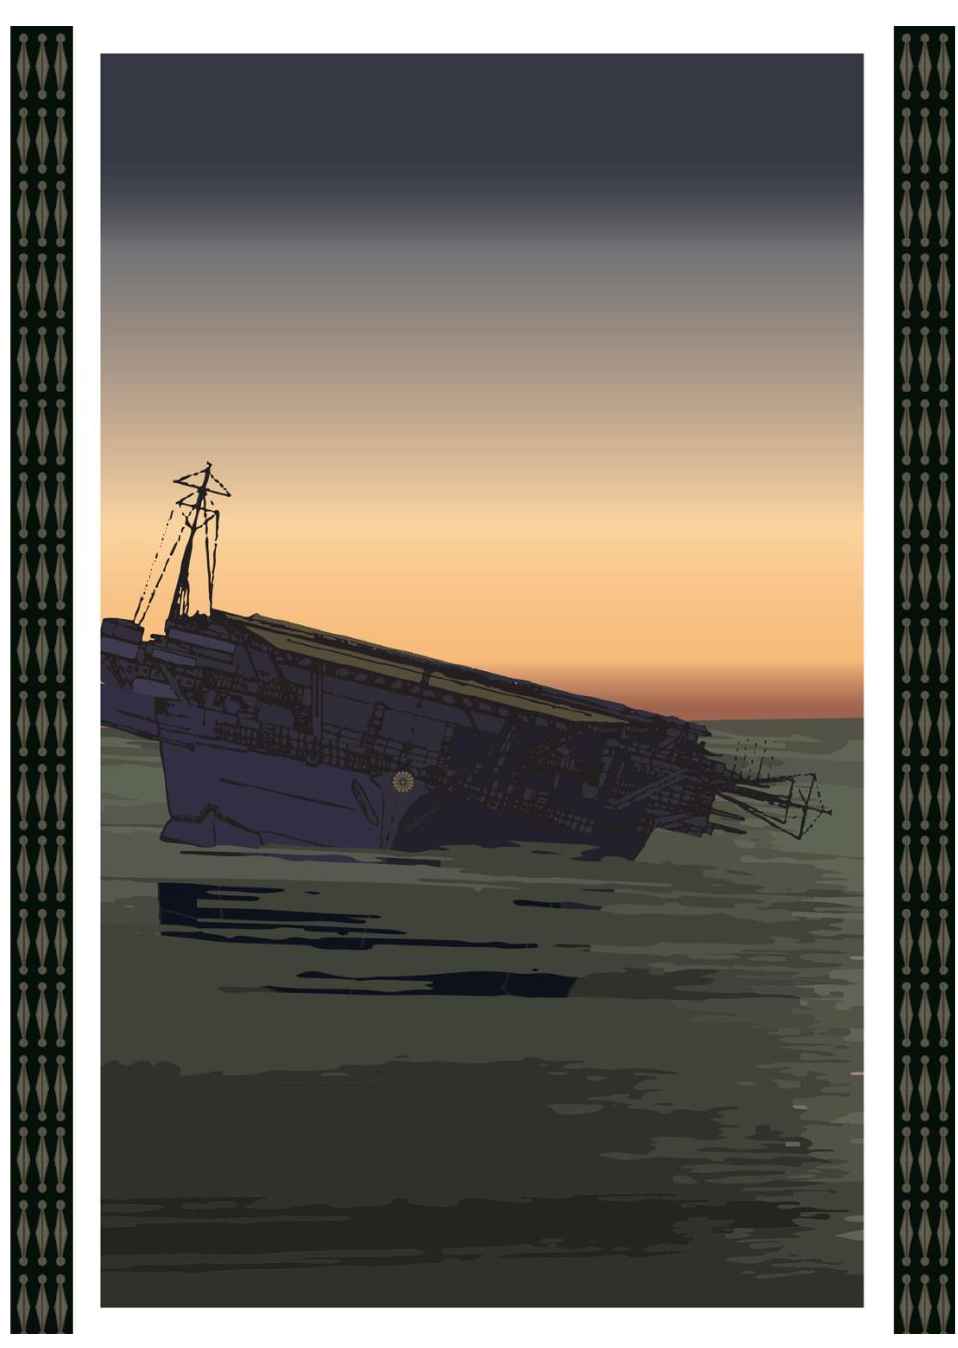
Kio Griffith, Eight Views of the Sun Setting on the South Pacific / IJN Shōhō , 2020. Digital collage print on